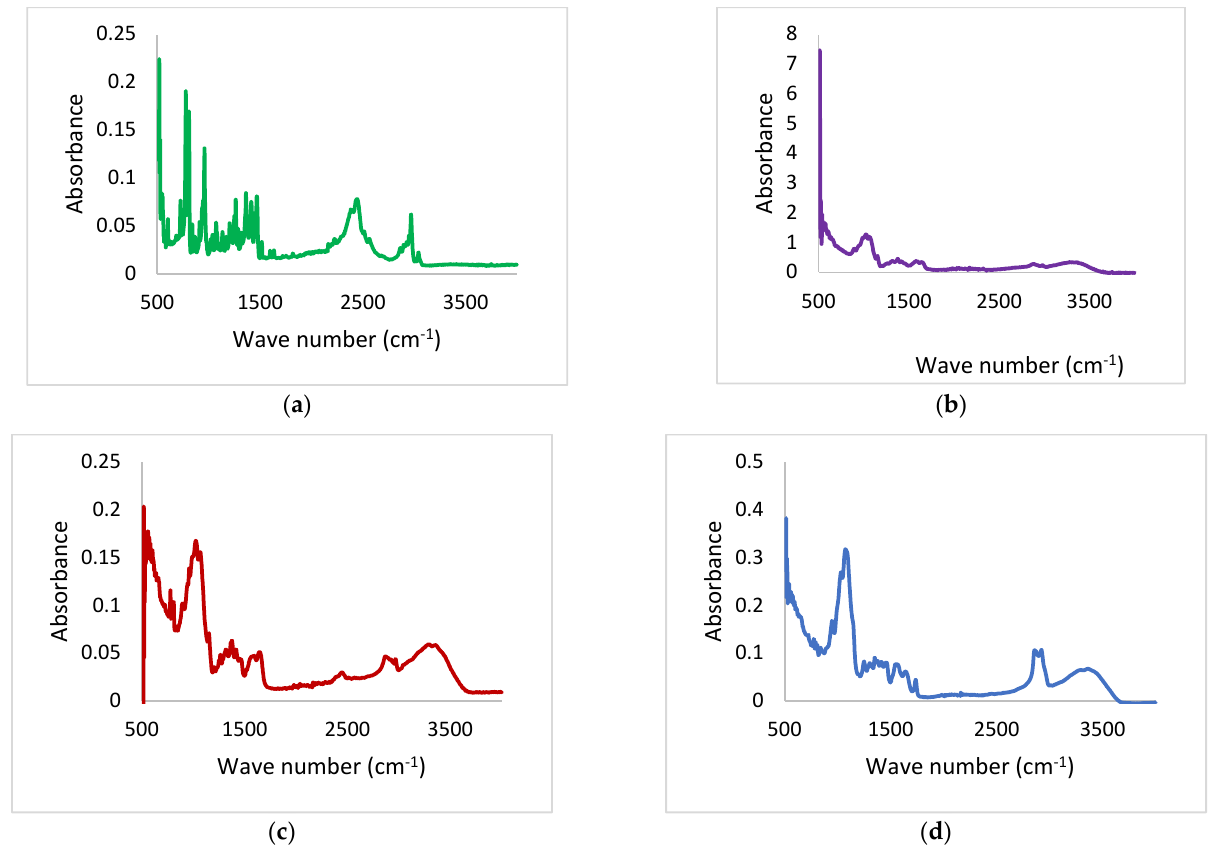
Figure 4. FTIR spectra of ( a ) pure drug, ( b ) polymer ( c ) Physical mixture, and ( d ) TBN-CSNP.